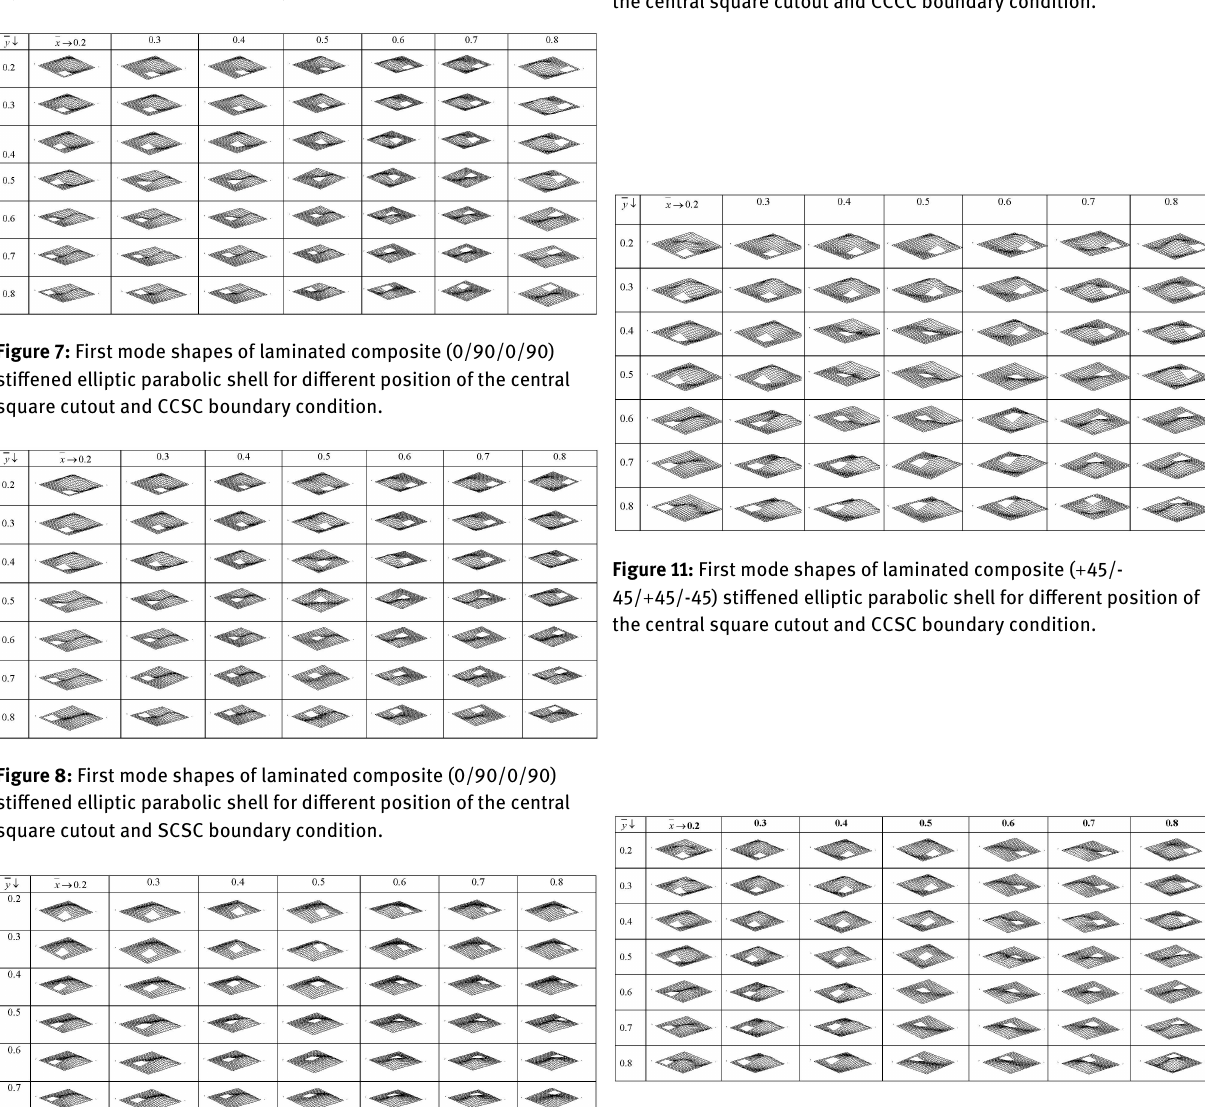
Figure 6: First mode shapes of laminated composite (0/90/0/90) stiffened elliptic parabolic shell for different position of the central square cutout and CCCC boundary condition